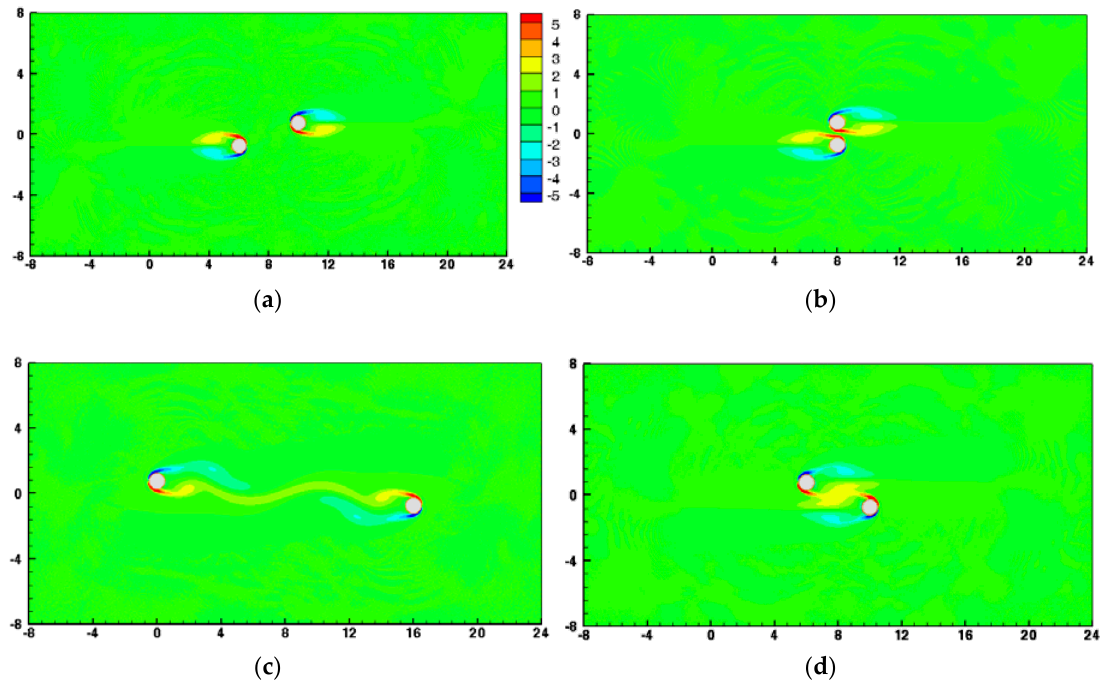
Figure 8. Instantaneous vorticity contours of two moving cylinders at Re = 100, at different times: ( a ) ˆt = 12 ( b ) ˆt = 16 ( c ) ˆt = 20 ( d ) ˆt =